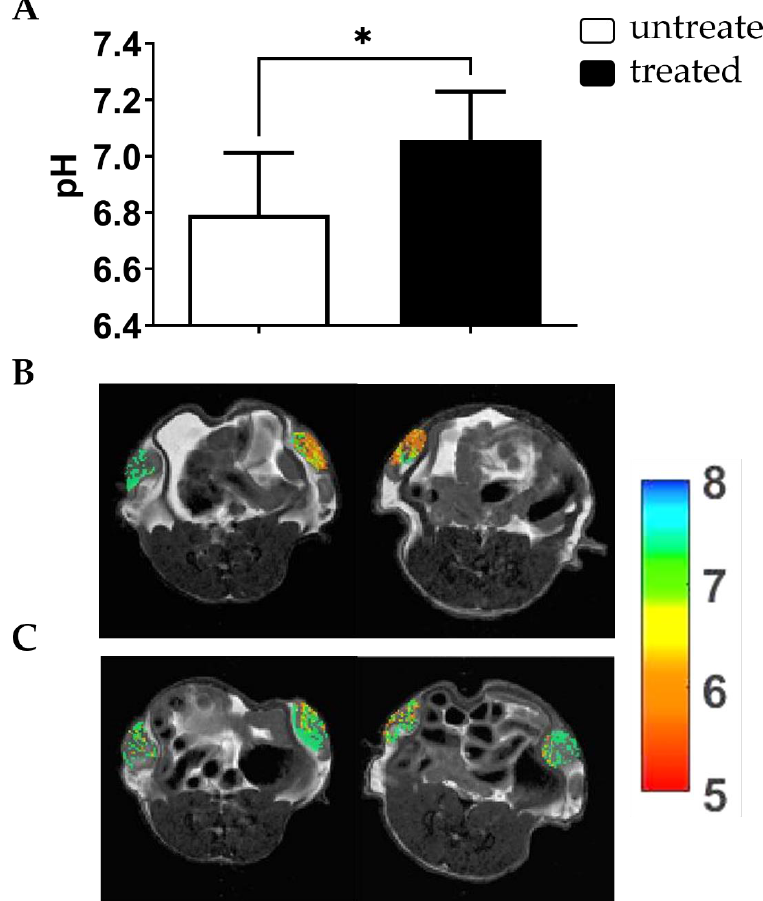
Figure 3 . Acute effect of Esomeprazole on tumor extracellular pH. MRI-CEST extracellular tumor pH values for DU145 subcutaneous tumors three hours after oral Esomeprazole administration (dose: 2.5 mg/kg b.w.) in treated ( n = 4) and untreated ( n = 4) groups (* p value < 0.05, unpaired Student’s t -test) ( A ). Tumor pH maps superimposed over T 2w anatomical images are shown for two representative untreated mice ( B ) and for two treated mice ( C ) showing a marked reduction in tumor acidic values upon Esomeprazole administration.